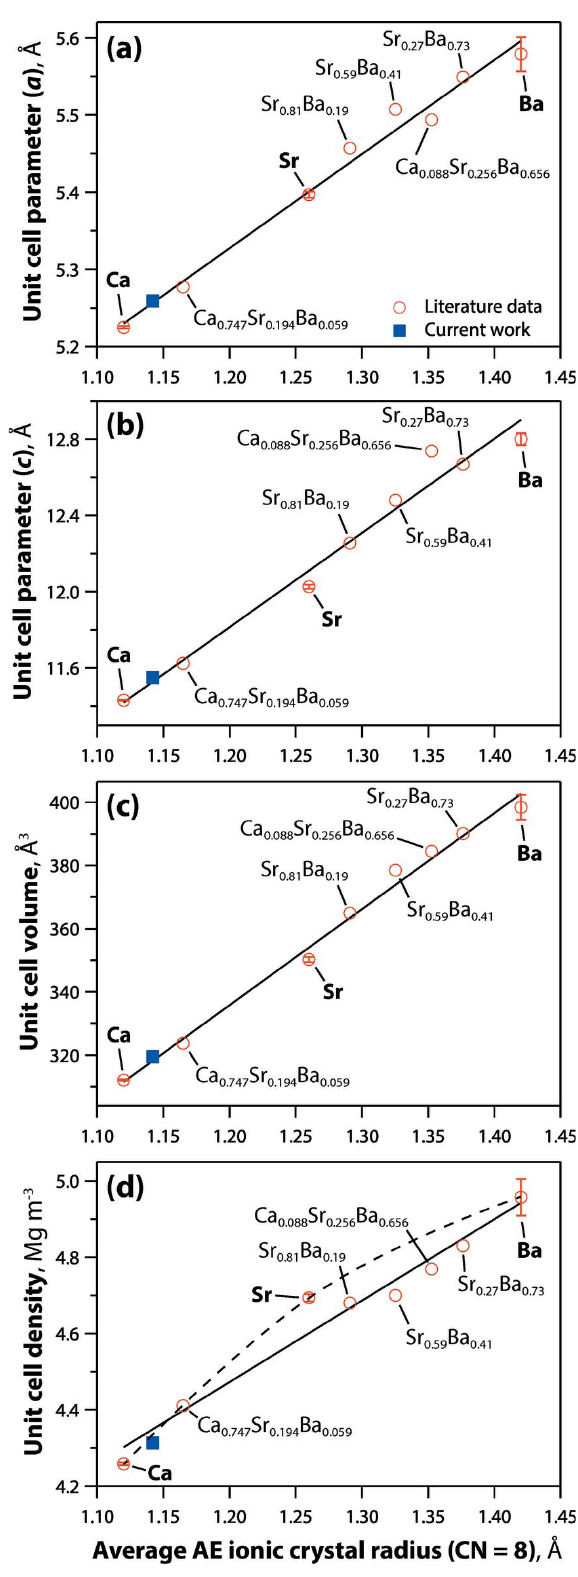
Figure 2 Summary of ( a ) unit-cell parameter a, ( b ) unit-cell parameter c, ( c ) unit- cell volume (V), and ( d ) density ( (cid:2) ) as a function of the average ionic crystal radii in the structure (coordination number = 8) from Shannon (1976). Data for the end members include averages and standard deviations from multiple sources.